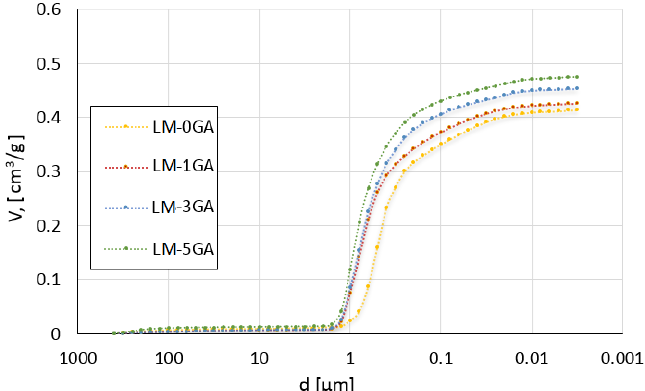
Figure 5. Cumulative volume of intruded mercury versus pore diameter for the tested lime-metakaolin pastes.